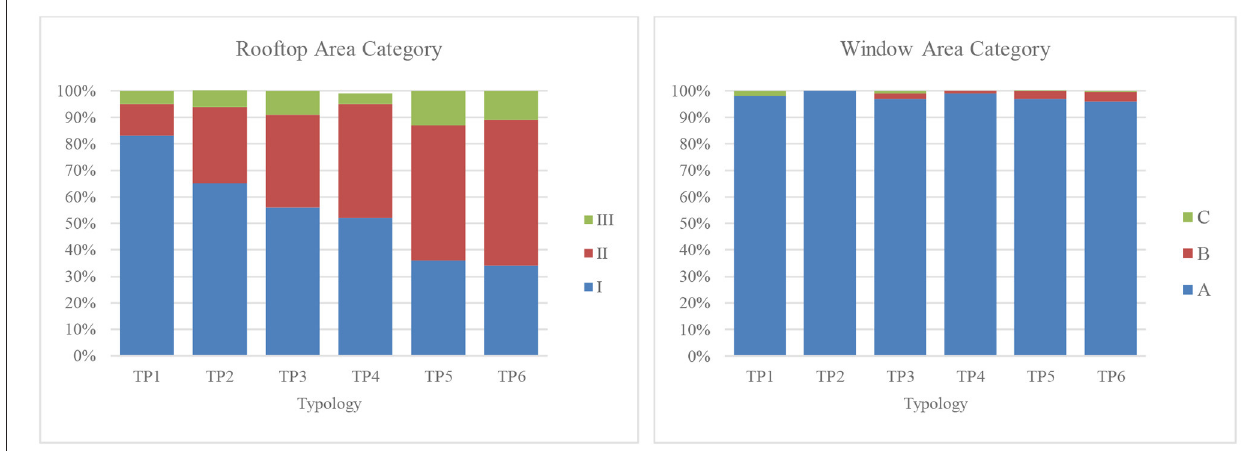
FIGURE 6 | Distribution of rooftop (I, II, III) and window area categories (A, B, C) by building typology for Alfama.